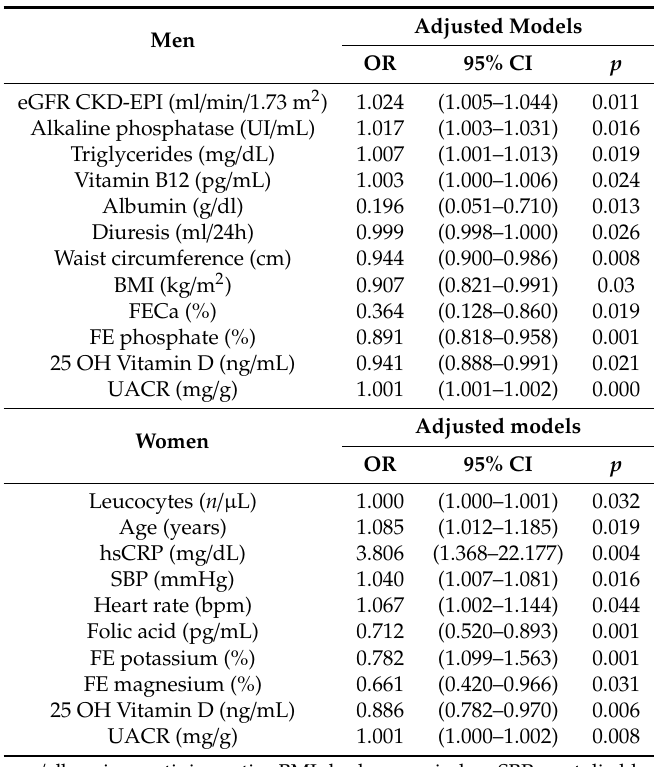
Table 2. Variables associated with rapid progression in men and women. Variable shown if p value ≤ 0.05, adjusted by eGFR measured by the Chronic Kidney Disease Epidemiology Collaboration) equation (CKD-EPI), age and urinary albumin / creatinine ratio (UACR) are shown. Adjusted Models Men OR 95%